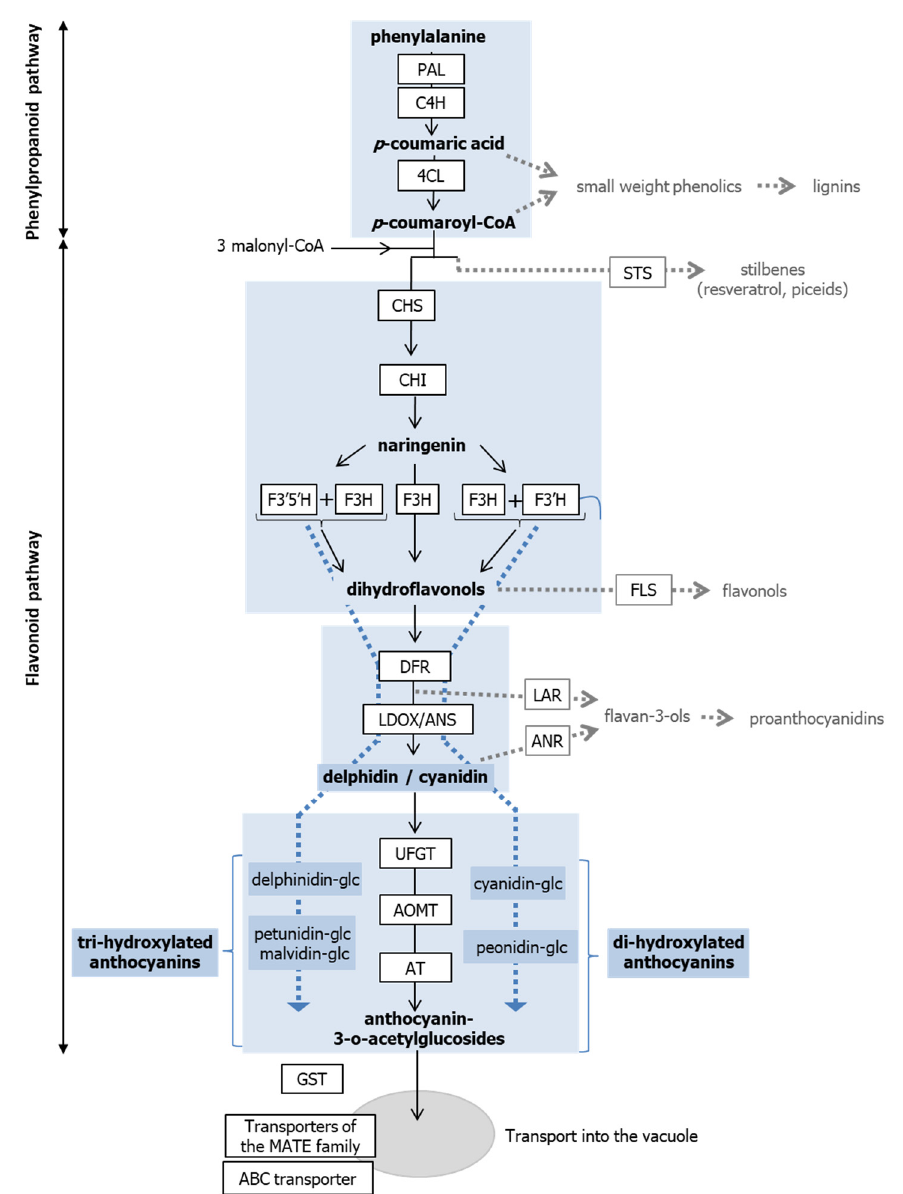
Figure 1. Anthocyanin biosynthesis pathway. Enzyme names are indicated in boxes. Enzyme names are as follows: PAL, phenylalanine ammonia lyase; C4H, cinnamate 4-hydroxylase; 4CL, 4- coumarate:CoA ligase; STS, stilbene synthese; CHS, chalcone synthase; CHI, chalcone isomerase; F3H, flavanone 3-hydroxylase; F3 ′ H, flavonoid 3 ′ -hydroxylase; F3 ′ 5 ′ H, flavonoid 3 ′ ,5 ′ -hydroxylase; FLS, flavonol synthase; DFR, dihydroflavonol 4-reductase; LAR, leucoanthocyanidin reductase; LDOX, leucoanthocyanidin dioxygenase; ANR, anthocyanidin reductase; UFGT, UDP glucose: flavonoid-3- O -glucosyltransferase; AOMT, anthocyanin O -methyltransferases; AT, anthocyanin 3- O -glucucoside-6 ″ - O -acyltransferase; GST, glutathione S-transferase; MATE, multidrug and toxic extrusion, ABC transporters, transporters of the ATP binding cassette protein family. In parallel to the biosynthesis pathway, important anthocyanin intermediates are shown in blue boxes: delphidin, delphinidin-glc, petunidin-glc, and malvidin-glc correspond to tri-hydroxylated molecules whose synthesis involves F3 (cid:48) 5 (cid:48) H and F3H. Cyanidin, cyanidin-glcm and peonidin-glc correspond to dihydroxylated molecules whose synthesis depends on F3 (cid:48) H and